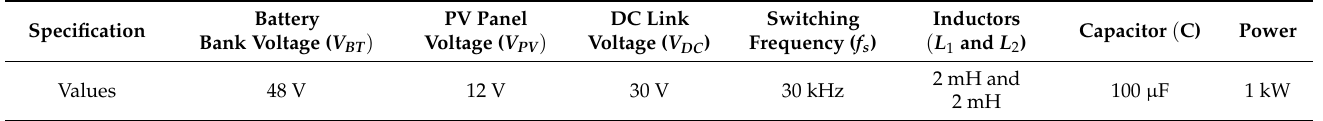
Table 3. Design specifications of the proposed converter.